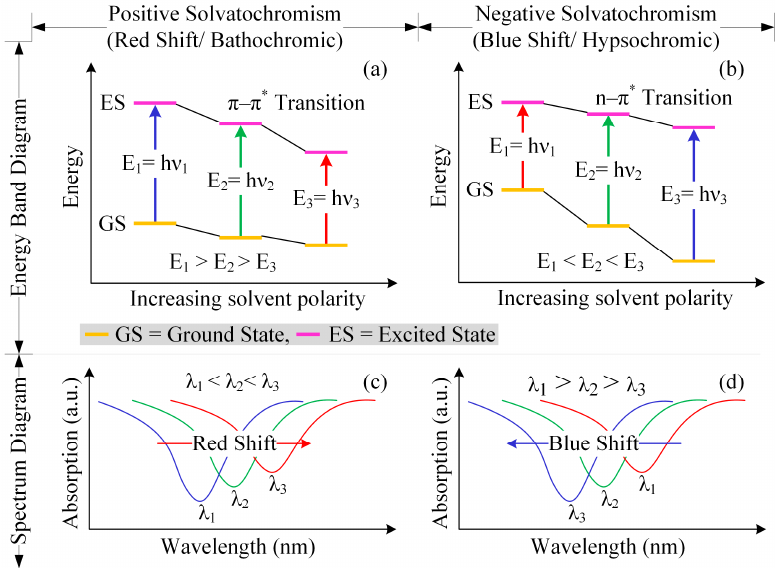
Figure 2. Representation of solvatochromism by: ( a ) energy band diagram of positive solvatochromism; ( b ) energy band diagram of negative Solvatochromism; ( c ) spectrum diagram of positive solvatochromism; and ( d ) spectrum diagram of neagative solvatochromism.